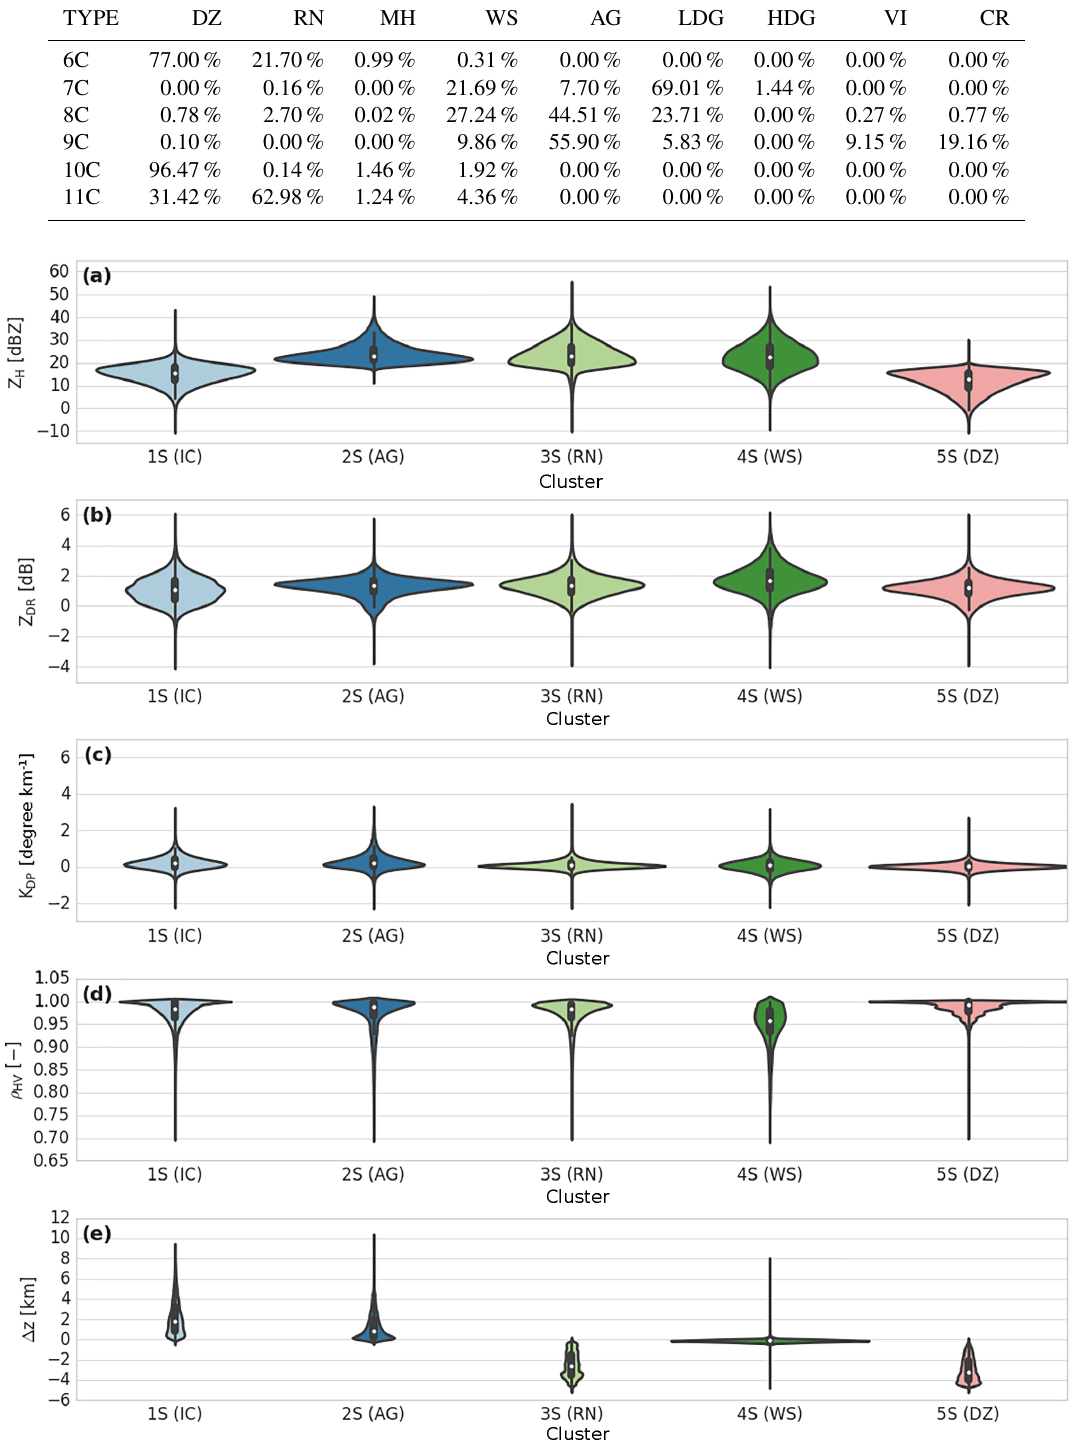
Figure 7. Violin plot of cluster outputs retrieved for the stratiform regime of the wet season (DZ is drizzle, RN is rain, WS is wet snow, AG is aggregates, and IC is ice crystals). The thick black bar in the centre represents the interquartile range, and the thin black line extended from it represents the 95% confidence intervals, while the white dot is the